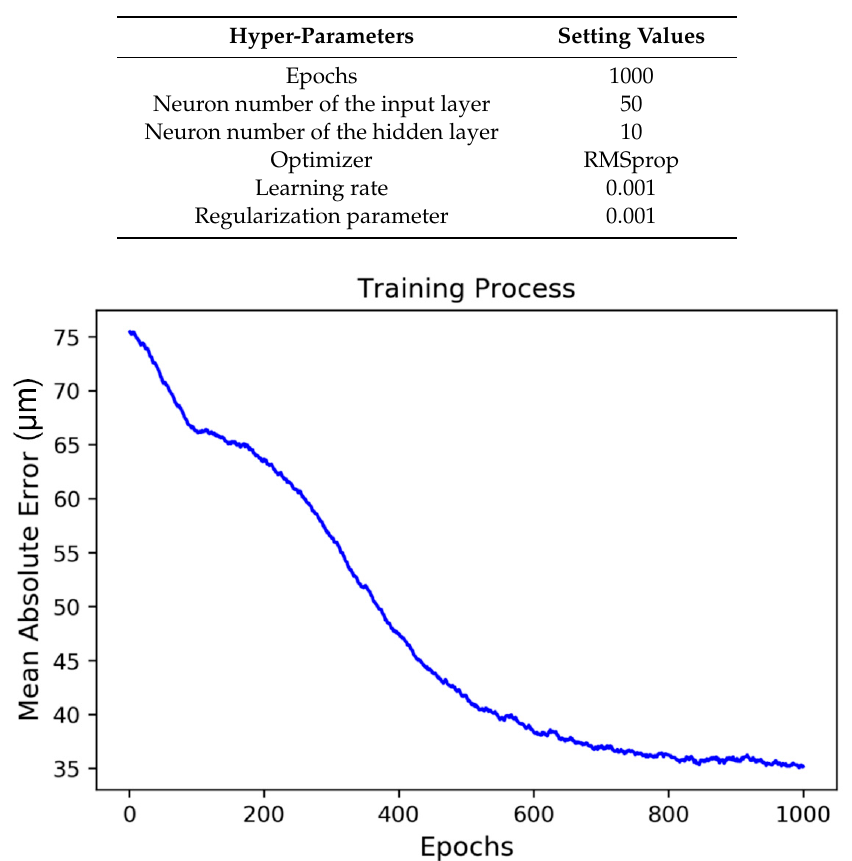
Figure 11. Mean absolute error of proposed deep learning model in training process.